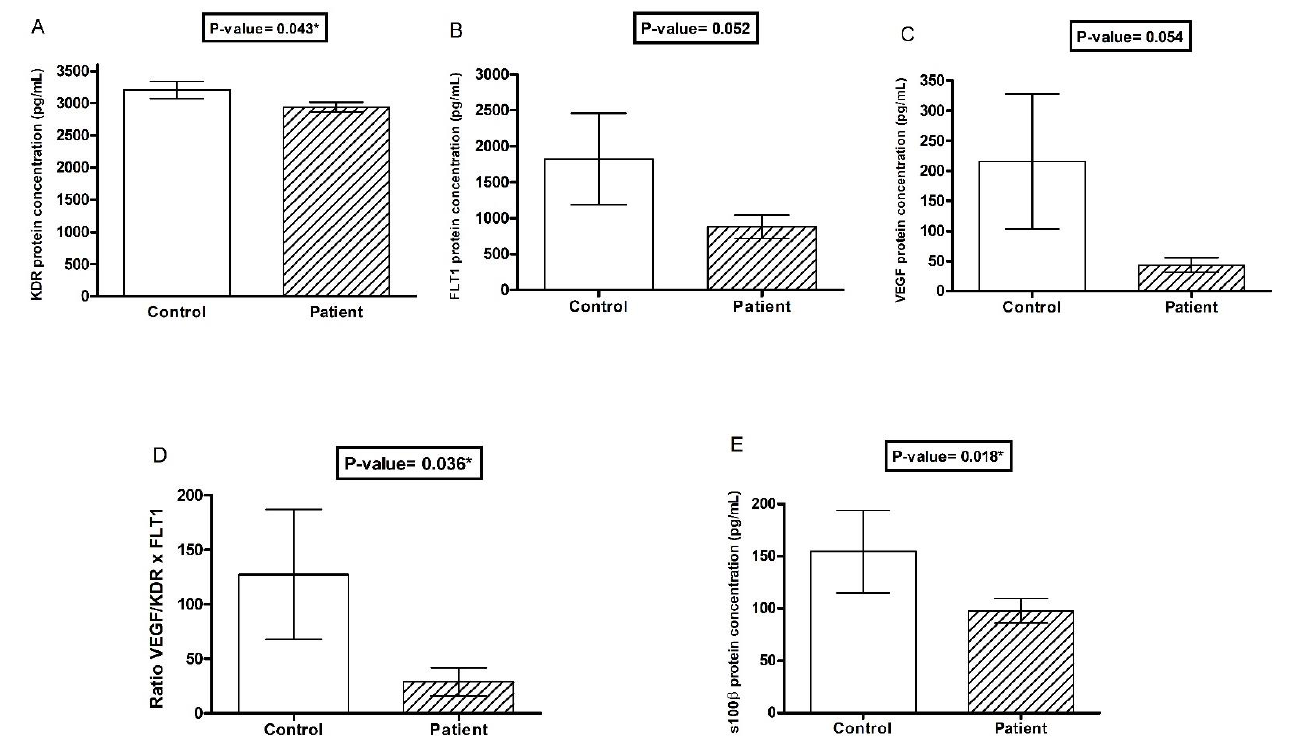
Figure 1. Distribution KDR, VEGF, FLT1, and s100 β plasma concentrations between VEGF and its inhibitors in control and patient groups. Legend: ( A ) KDR plasma concentration; ( B ) FLT1 plasma concentration; ( C ) VEGF plasma concentration; ( D ) ratio between VEGF and its inhibitors plasma concentration; ( E ) s100 β plasma concentration. All plasma concentrations were expressed as mean and standard deviation. Mann–Whitney test. * p < 0.05 was considered statistically significant.